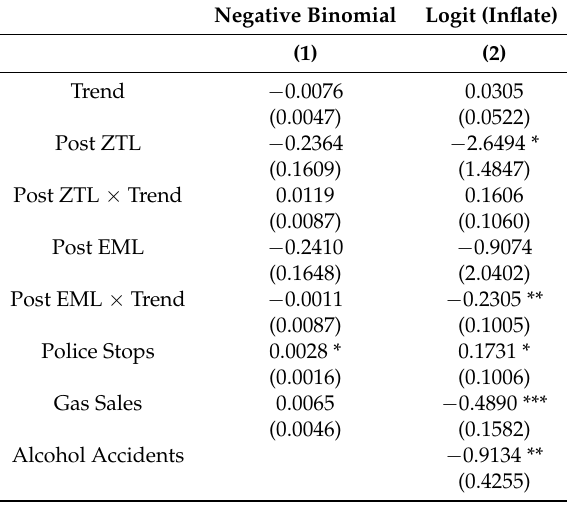
Table A1. Zero-inflated Negative Binomial